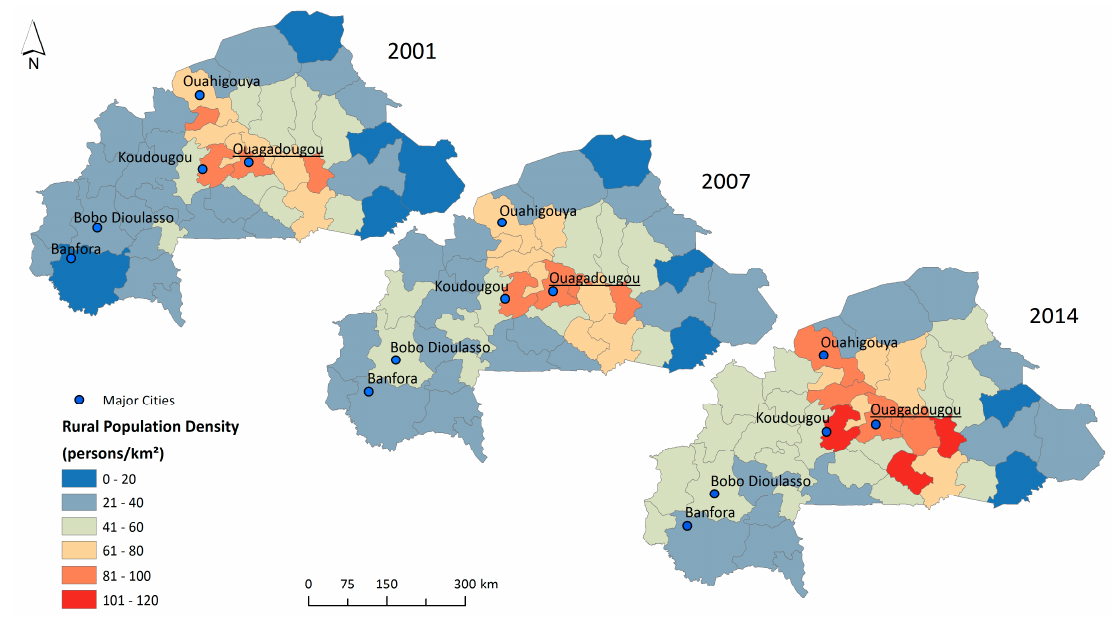
Figure 2. Development of rural population density in the provinces of Burkina Faso between 2001 and 2014 [35].